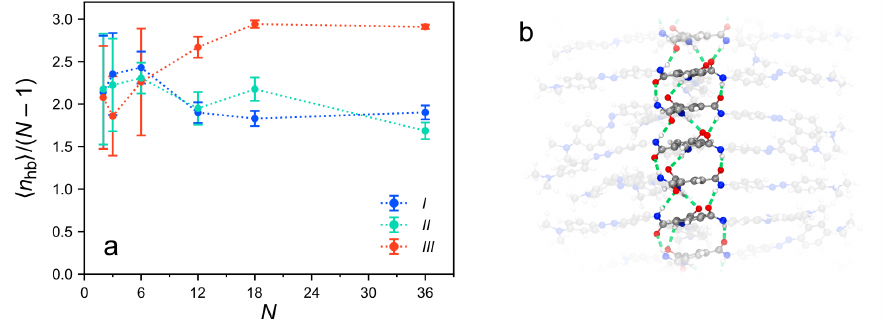
Figure 11. ( a ) Average number of hydrogen bonds per neighboring pair as a function of the cluster size N . Different cluster types are distinguished by color. Dotted lines serve as a guide to the eye. ( b ) Detail of an MD snapshot showing a TrisAzo stack (cluster type III , N = 18) with indicated hydrogen bonds (dashed green lines). The BTA centers are highlighted to improve visibility. The full snapshot is shown in Figure